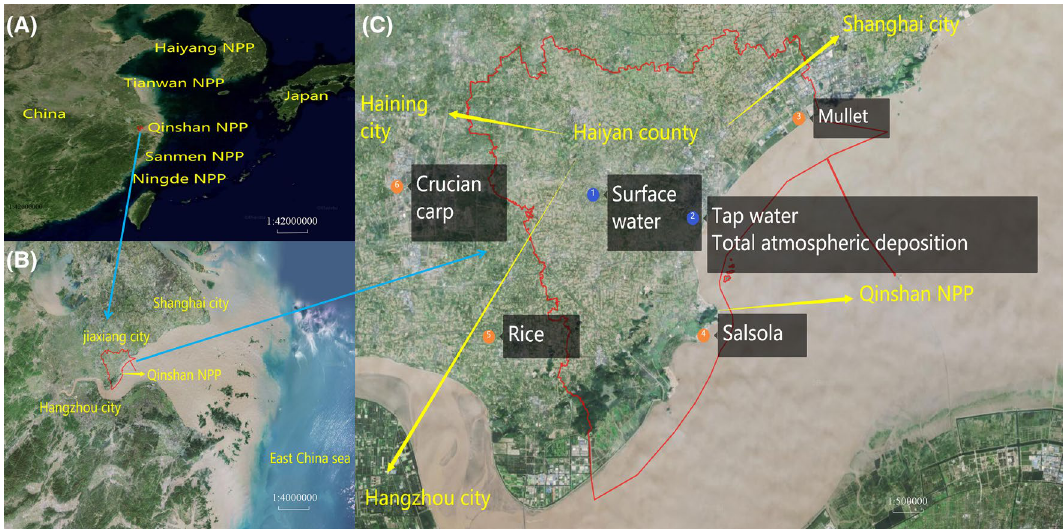
Figure 1. Map showing the geographical location of QNPP ( A , scale: 1:42,000,000) and ( B , scale: 1:4,000,000), and sampling sites in the surroundings of QNPP marked with filled circles and numbers ( C , scale: 1:500,000). The map was produced using software MapInfo Professional using data from https:// bajiu. cn/ ditu/.